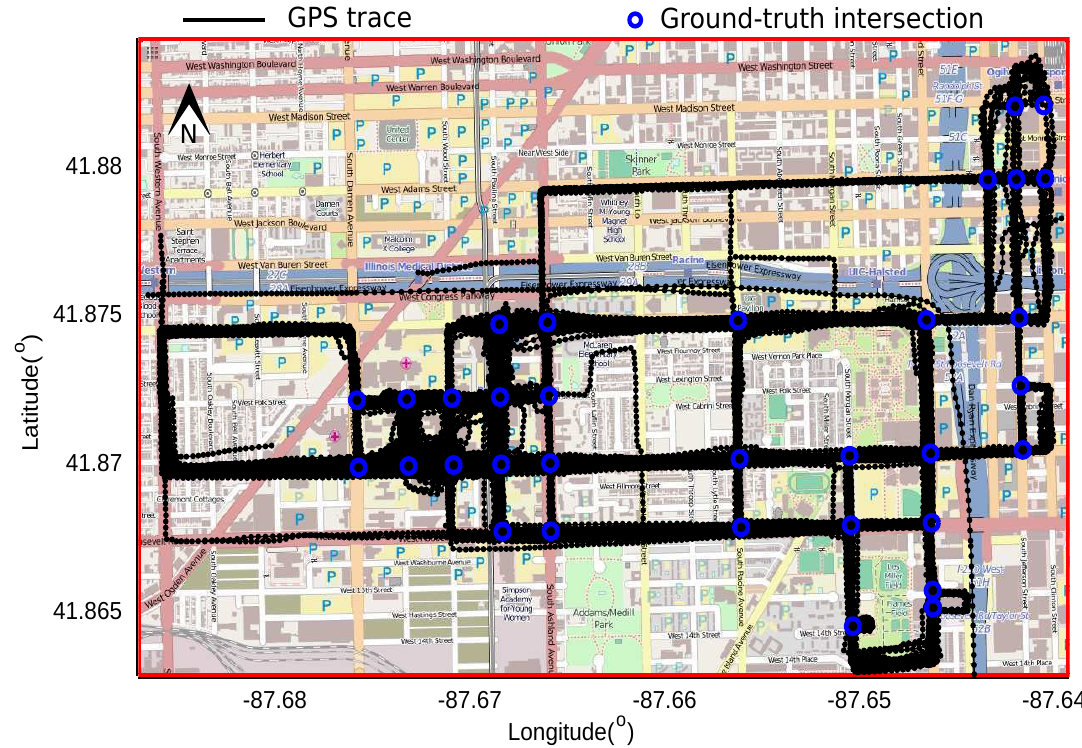
Figure 8. GNSS traces and the ground truth intersections. A total of 889 GNSS traces are shown by the black lines with dots indicating the point locations, and the 33 ground truth intersections are depicted with blue